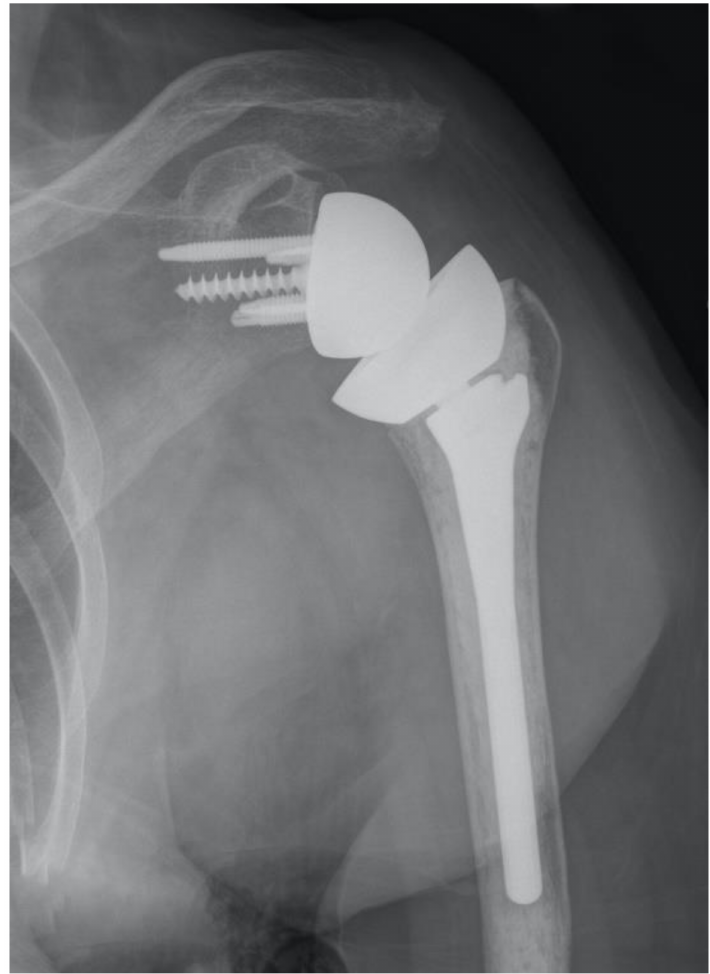
Figure 5. This implant was designed as an inlay, but its large size resulted in an onlay application most of the